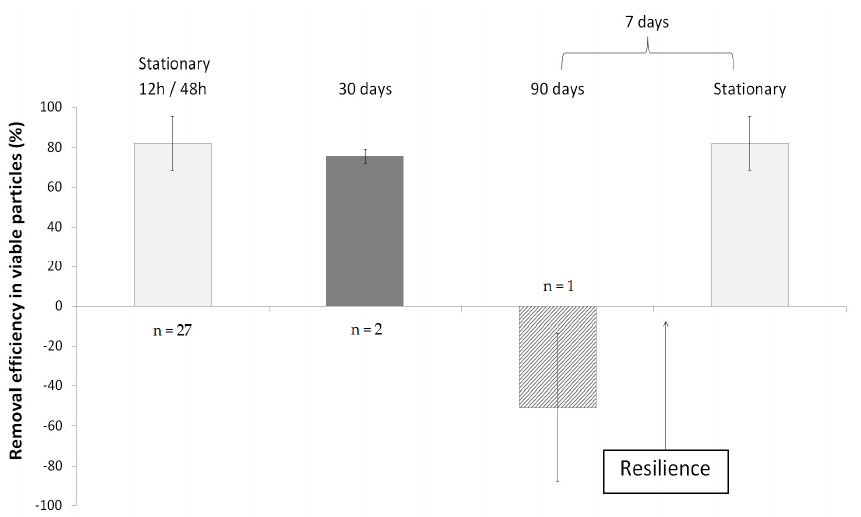
Figure 3. RE vp during the different deprivency periods (12 h/48 h, 30 and 90 days). The time required to recover the RE vp at steady state is of seven days.